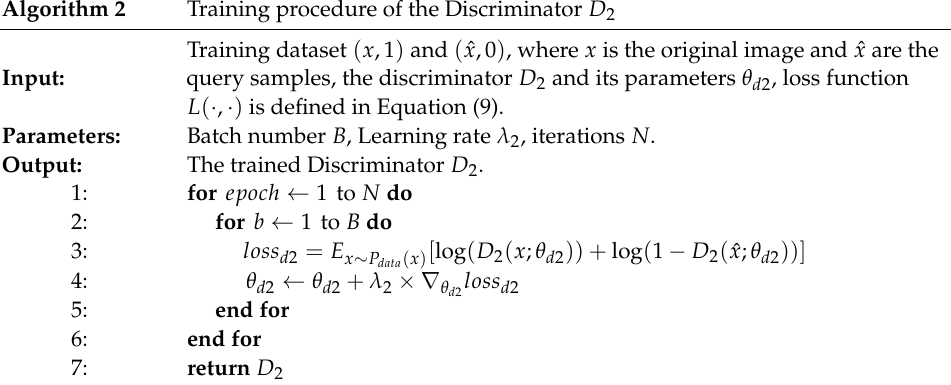
Algorithm 2 Training procedure of the Discriminator D